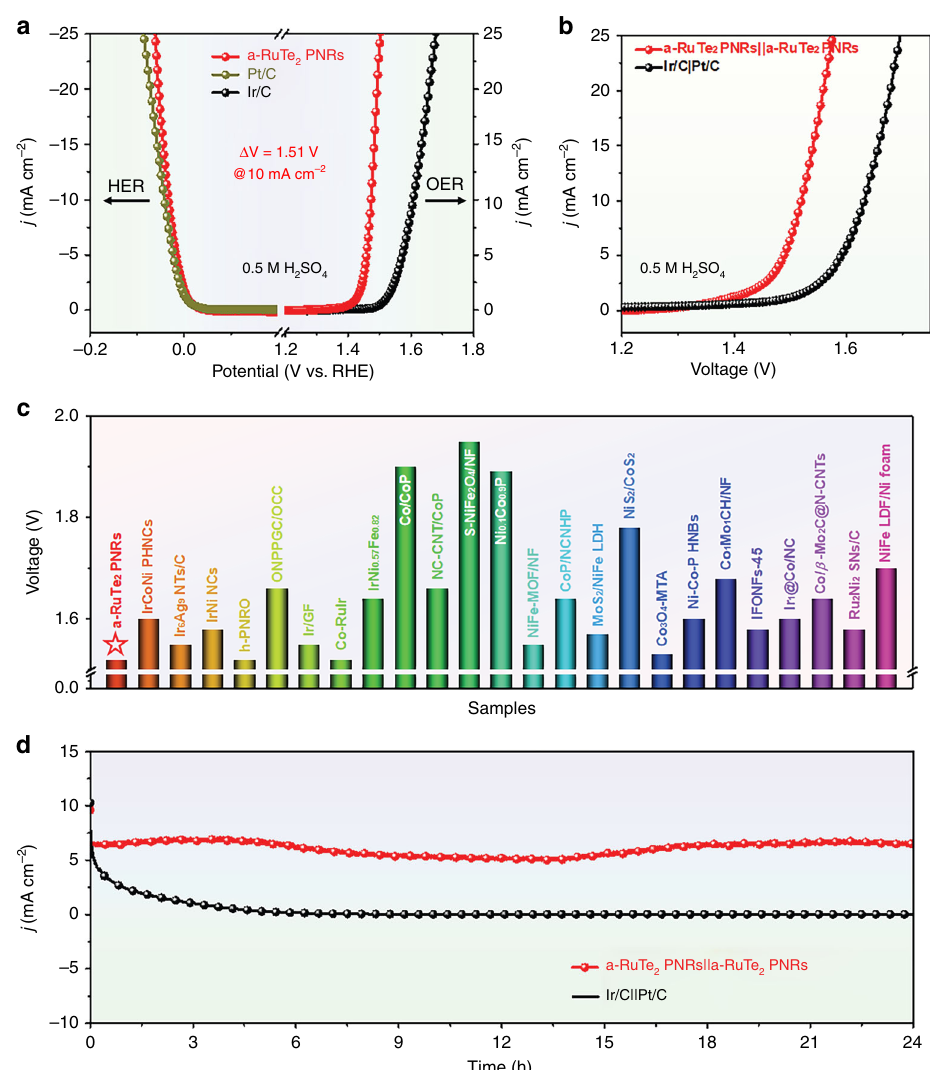
Fig. 7 Overall water splitting studies of catalysts in acidic media. a Polarization curves of a-RuTe 2 PNRs, commercial Pt/C and Ir/C in 0.5 M H 2 SO 4 for HER and OER. b Polarization curves of a-RuTe 2 PNRs||a-RuTe 2 PNRs and Ir/C||Pt/C in 0.5 M H 2 SO 4 for water splitting. c Comparison of the overpotential of a-RuTe 2 PNRs and recently reported overall water splitting electrocatalysts at 10 mA cm − 2 . d Time-dependent current density curves of a-RuTe 2 PNRs|| a-RuTe 2 PNRs and Ir/C||Pt/C for water splitting in 0.5 M H 2 SO 4